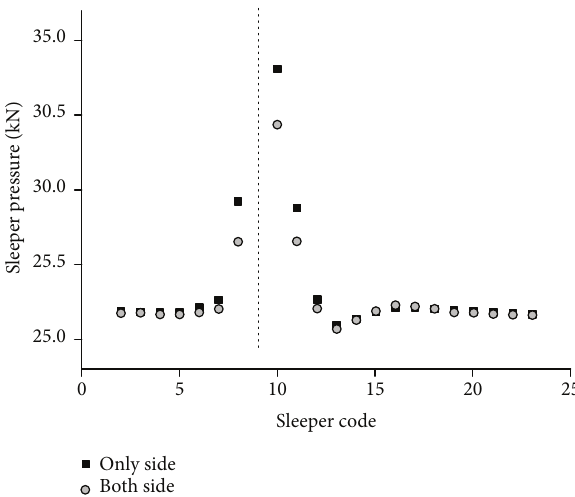
Figure 12: Sleeper pressure caused by one-side voided sleeper. Figure 13: Pressures on sleeper corresponding to different condi- tions of voided sleeper.